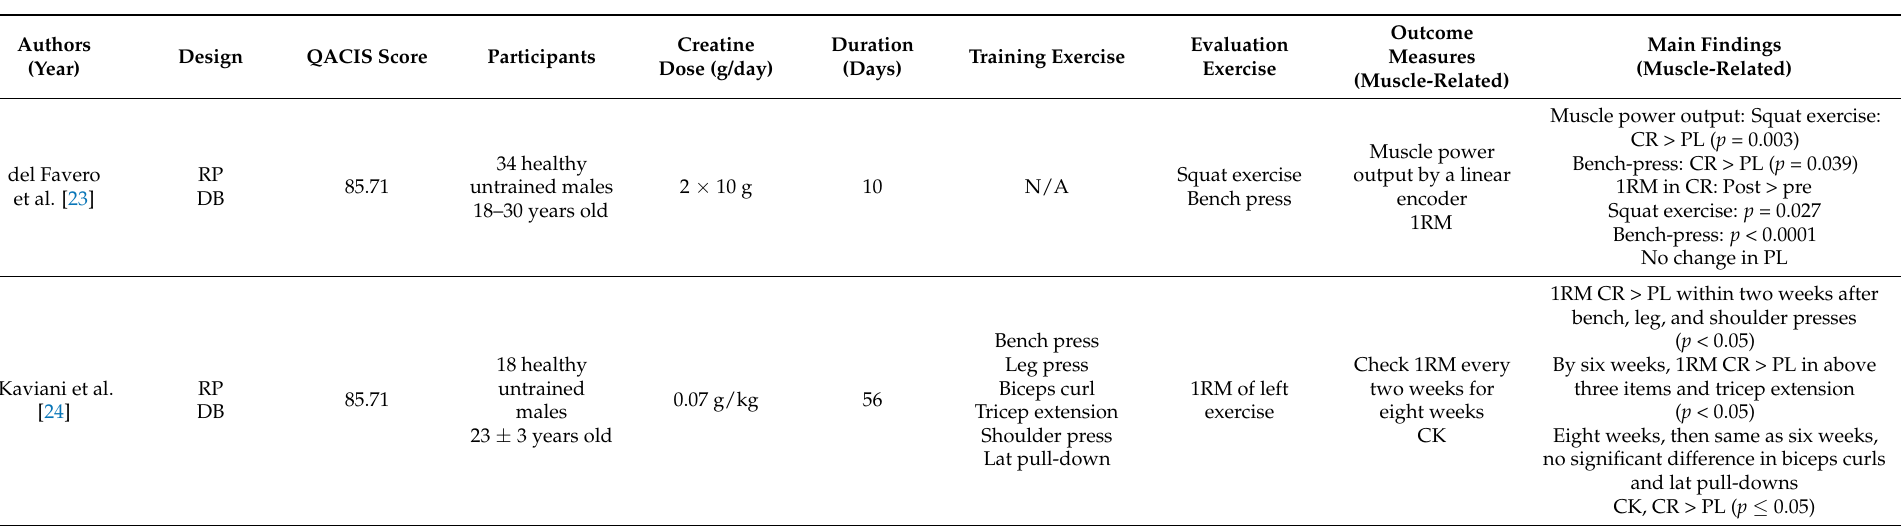
Table 1. Studies recruiting healthy untrained young subjects.